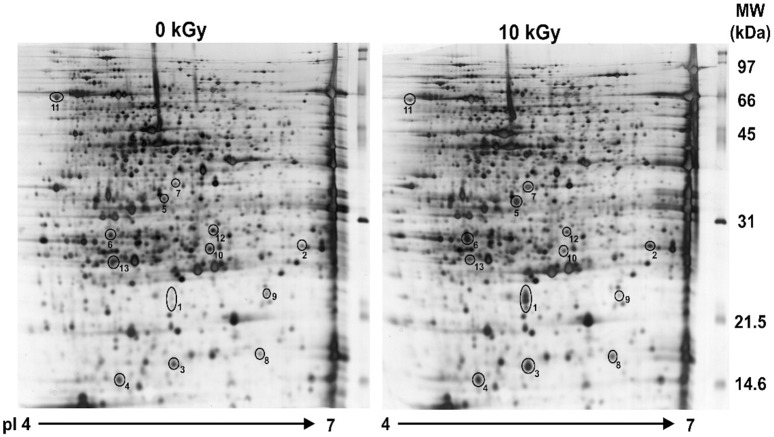
Protein profiles of non-irradiated and irradiated D. radiodurans.
D. radiodurans R1 cultures were exposed to 10 kGy of γ-radiation and allowed to recover for 1 h. Whole-cell proteins were extracted and resolved by isoelectric focusing in the first dimension using 4–7 IPG strips and by 12% SDS-PAGE in the second dimension. The protein spots (marked in circles) that displayed significant differences in expression were selected for further analysis.